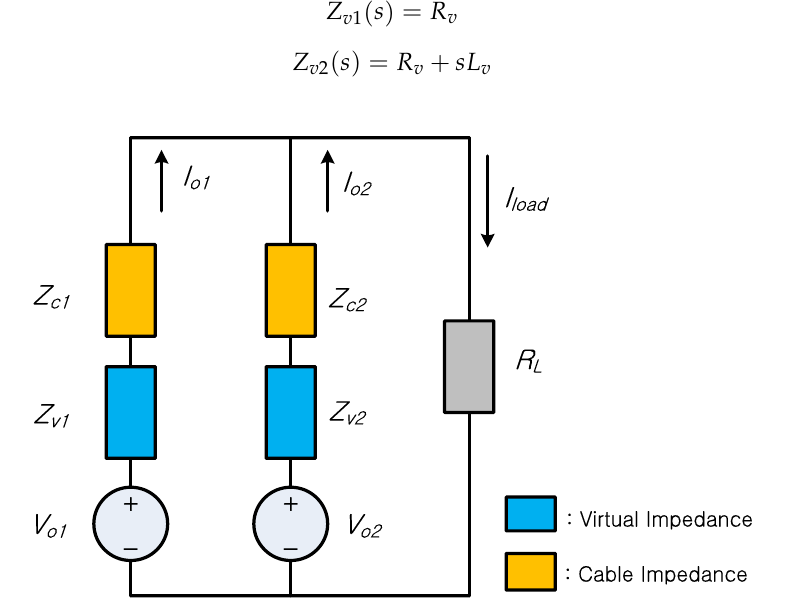
Figure 7. Equivalent circuit of an EPS with two sources connected in parallel.